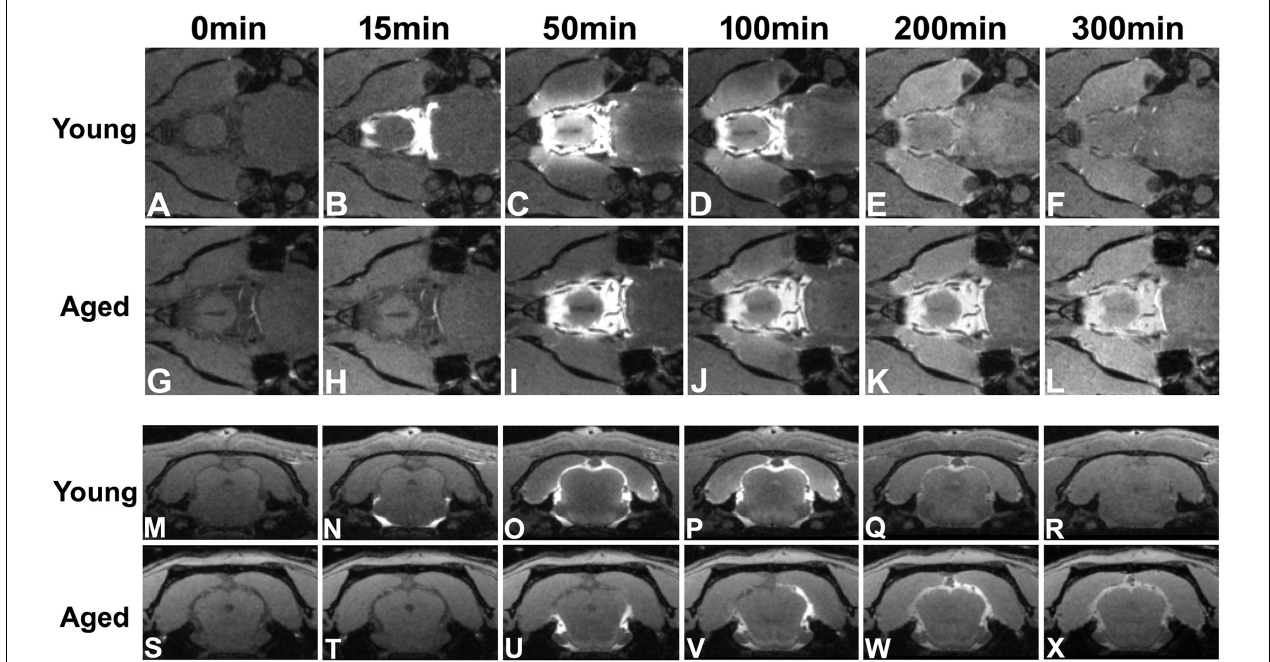
FIGURE 4 | Flow of contrast at the level of circle of Willis (A–L) and the level of pineal gland ( M–X , Bregma − 7.92 mm) in the representative young and aged rat brain (the same animals shown in Figure 3 ). Earlier arrival ( B vs. H ) and shorter retention period (from B–D vs. from I–L ) of contrast at the level of circle of Willis were present in the young brain than in the aged brain. With time after intracisternal injection, the movement of contrast from the base of the brain toward the pineal gland was captured in both young (comparing N with O ) and aged (comparing U with V,W ) brain. However, much slower progression (from N–O vs. from U–W ) and more sluggish clear-out ( R: almost clean vs. X: still retained) of contrast over time were found in the aged brain than in the young